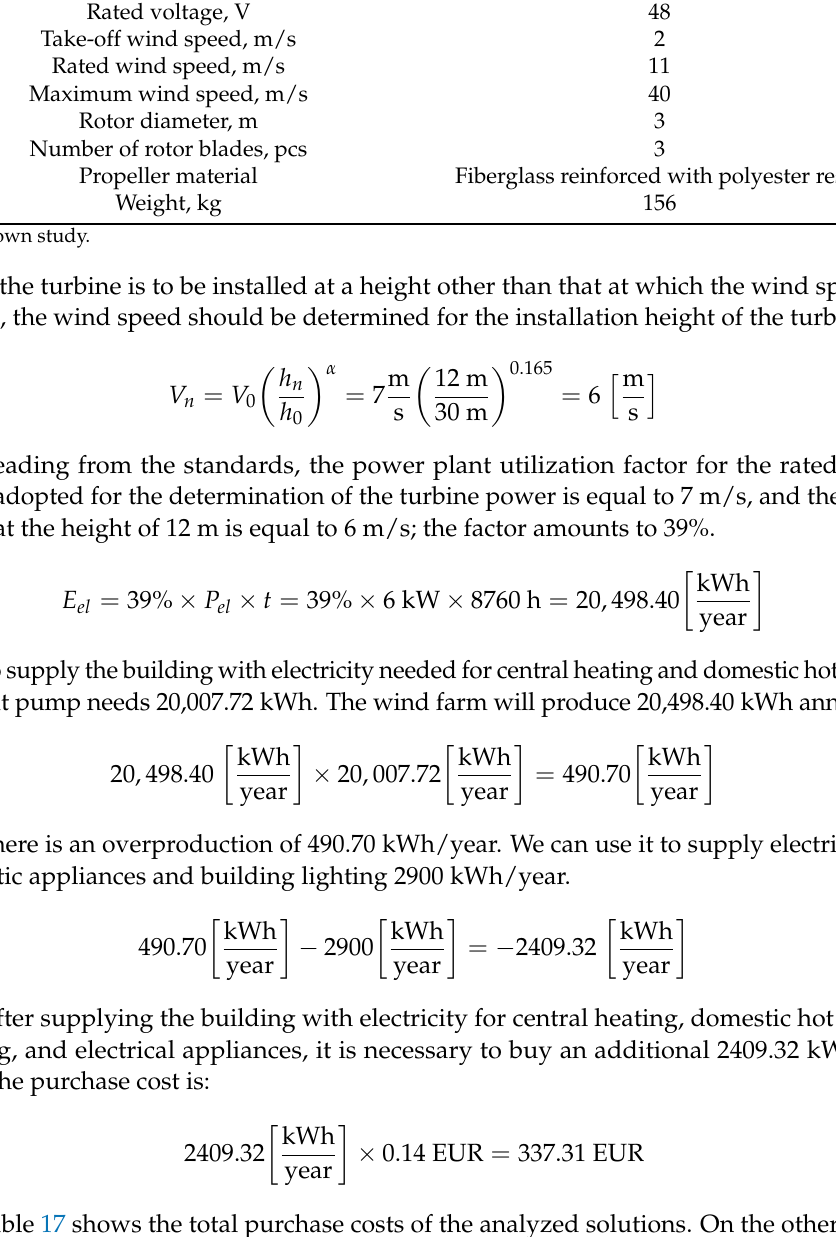
Table 16. Technical parameters of the Spine + ARC 1500 turbine. Technical Parameters of the Wind Turbine Rated power, kW 6 Rated voltage, V